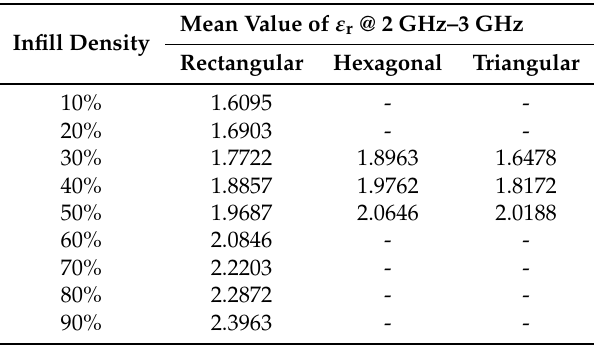
Figure 11. Microscope images of rectangular, hexagonal, and triangular infill pattern of 30% infill density. Table 4. Relative permittivity of different